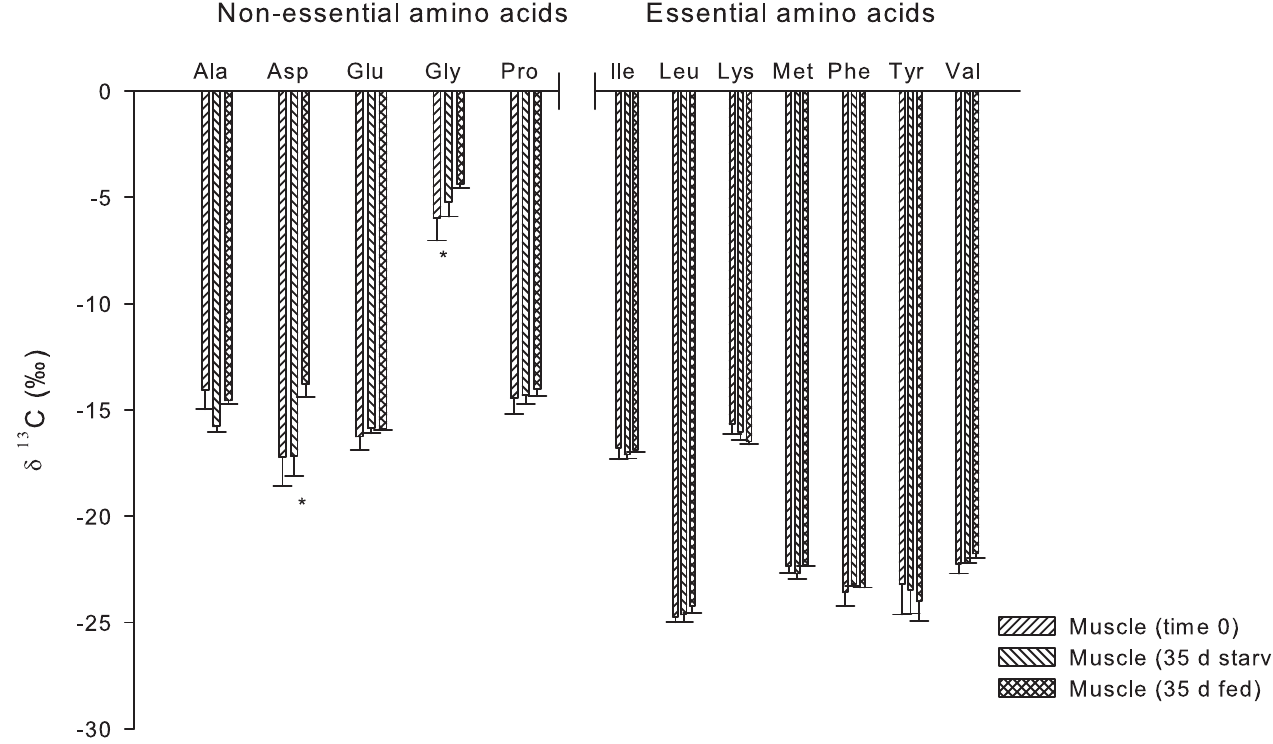
Fig 4. Compound specific δ 13 C of amino acids of S . lalandi muscle: Time 0, Muscle 35 d starvation and muscle 35 d fed, averageand standard deviation. Asterix ( * ) denotes statistically significantdifference between time 0 and 35 days of